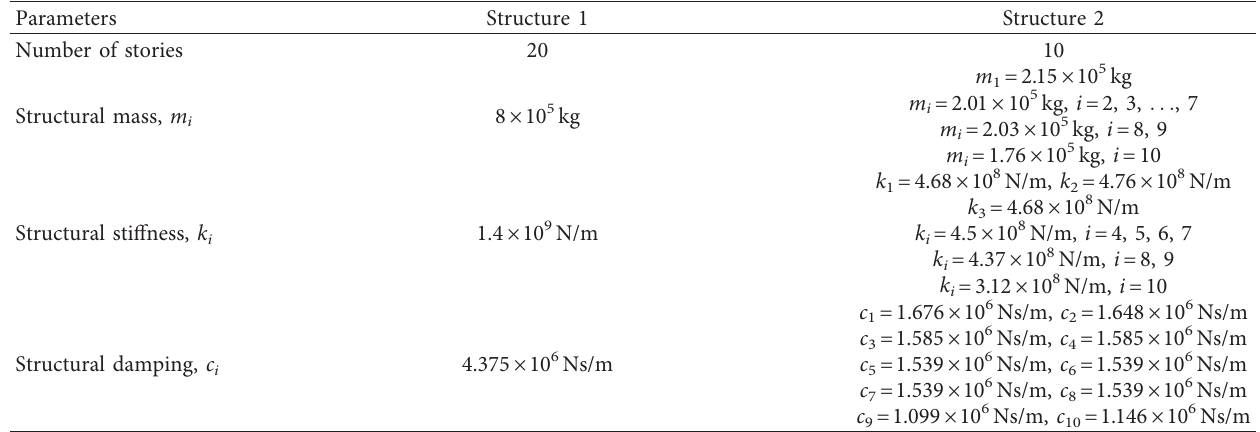
Table 3: Structural parameters of the adjacent buildings